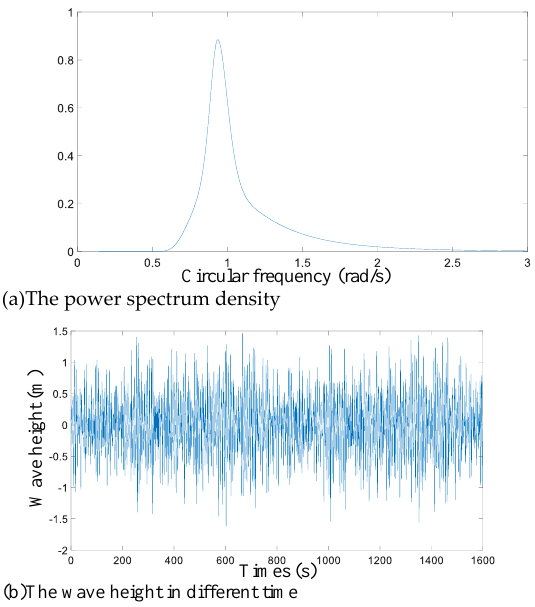
Fig. 5. The irregular waves (JONSWAP wave spectrum: 𝐻 𝑠 = 2𝑚 , 𝛾 = 3 and 𝜔 𝑚 = 1𝑟𝑎𝑑/𝑠